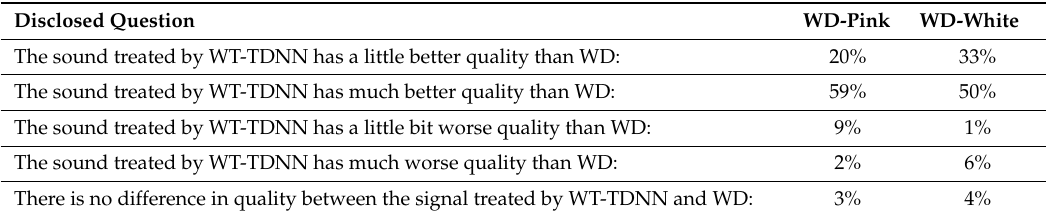
Table 5. Summary of questionnaire with averaging